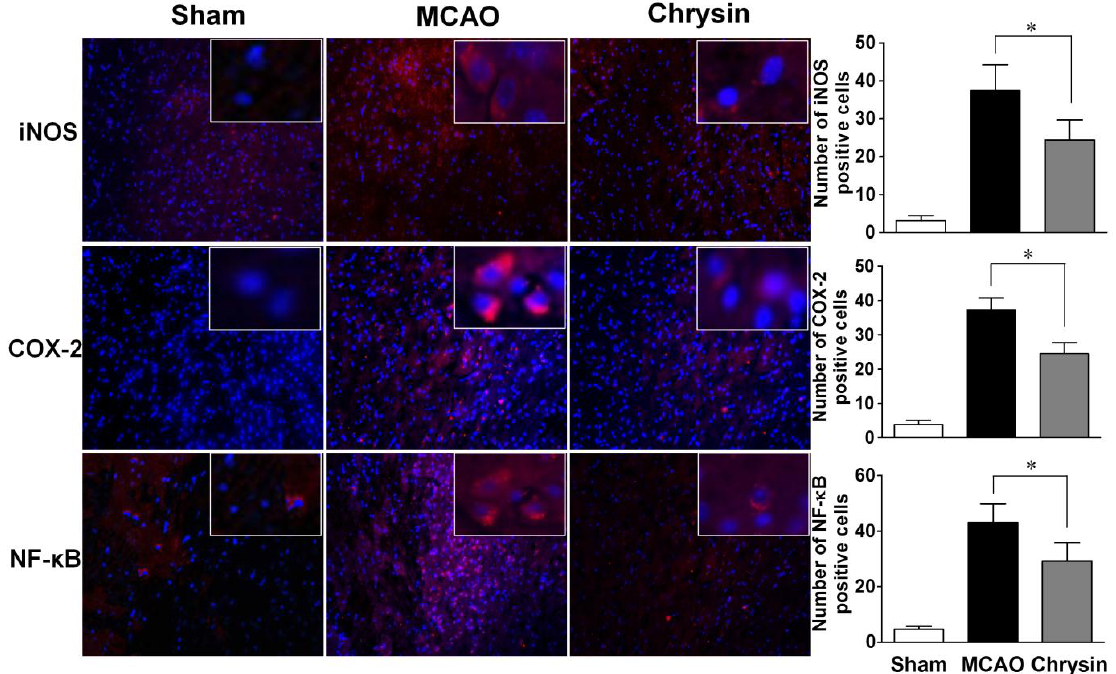
Figure 3. Chrysin pretreatment suppresses the production of iNOS , COX-2 and NF-κB in the I/R injured mouse brain. Representative coronal brain sections of the sham group, the MCAO group and the chrysin pretreatment group were stained using immunofluorescence for iNOS , COX-2 and NF-κB . The sham group showed negligible staining. However, the expression of iNOS , COX-2 and NF-κB was prominent in the MCAO group compared with the sham group, and the chrysin pretreatment group showed moderate staining for iNOS , COX-2 and NF-κB (Magnified 20×). Data are expressed as means ± SEM, * p < 0.05, vs. MCAO group, n = 6.